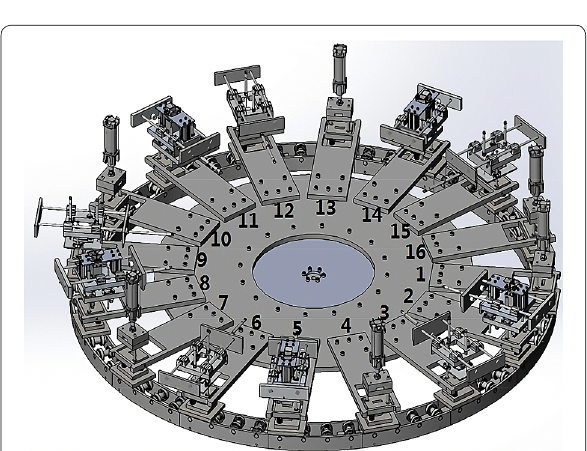
Figure 5 Schematic of rotary working platforms: 1, 4, 7, 10, 13. Stations for loading metal powders; 2, 5, 8, 11, 14. Stations for ordered arrangement of diamond grits; 3, 6, 9, 12, 15. Stations for cold pressing; 16. Station for segment